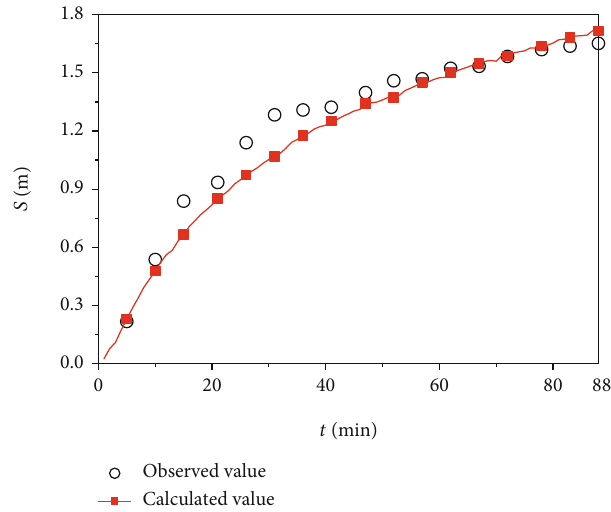
Figure 8: Measured observation borehole hydraulic head h and calculated hydraulic head by the non-Darcian fl ow model of the second test for validating obtained non-Darcian fl ow